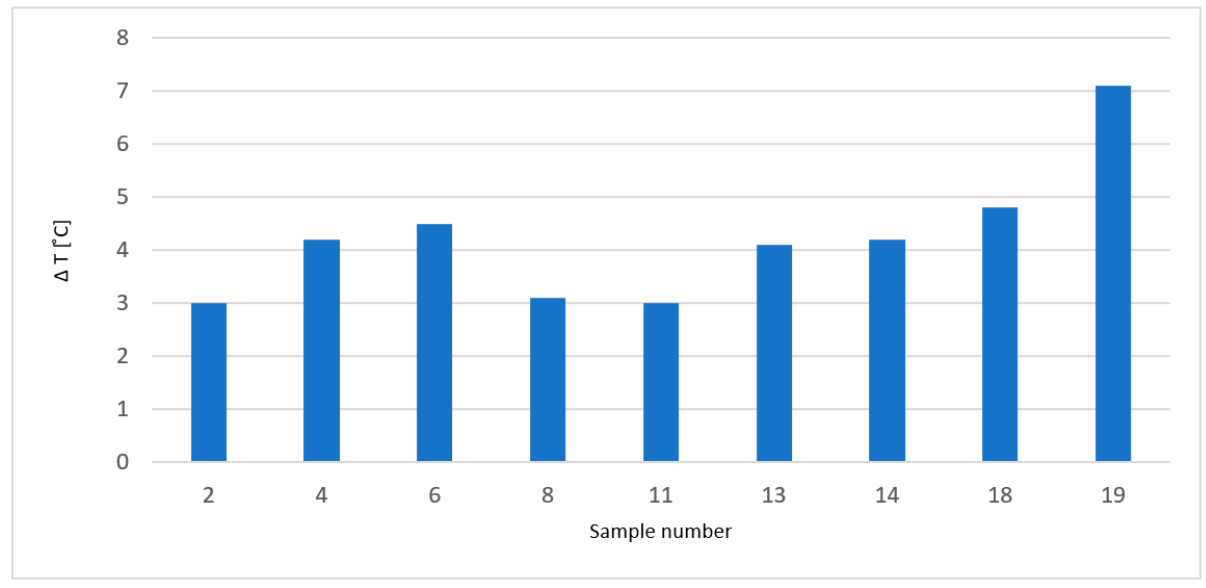
Figure 16. Temperature differences on the condensers and evaporators of individual heat pipes.